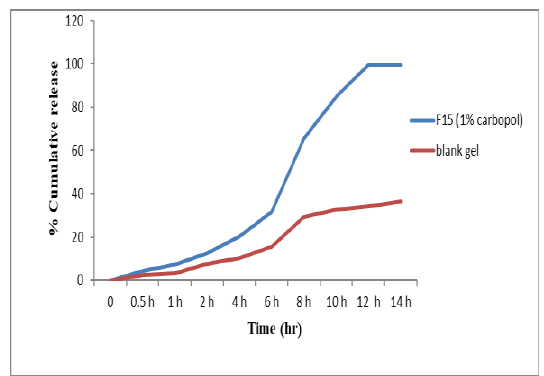
Figure 10. The cumulative release of AC for gelled F15 and blank